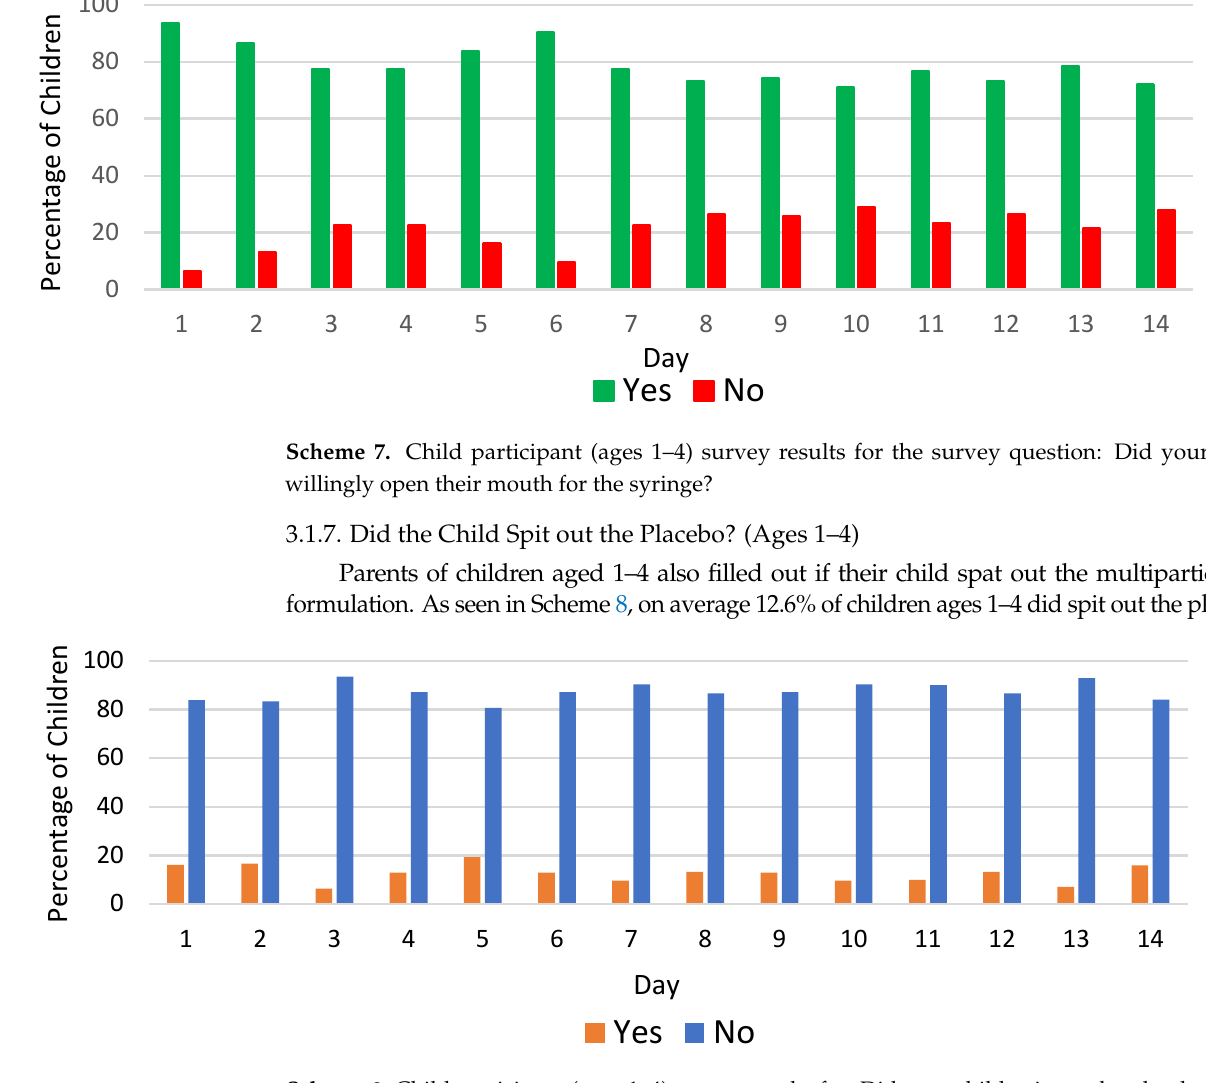
Scheme 6. Child participant (ages 5–12) survey results for: Taste of the sample.